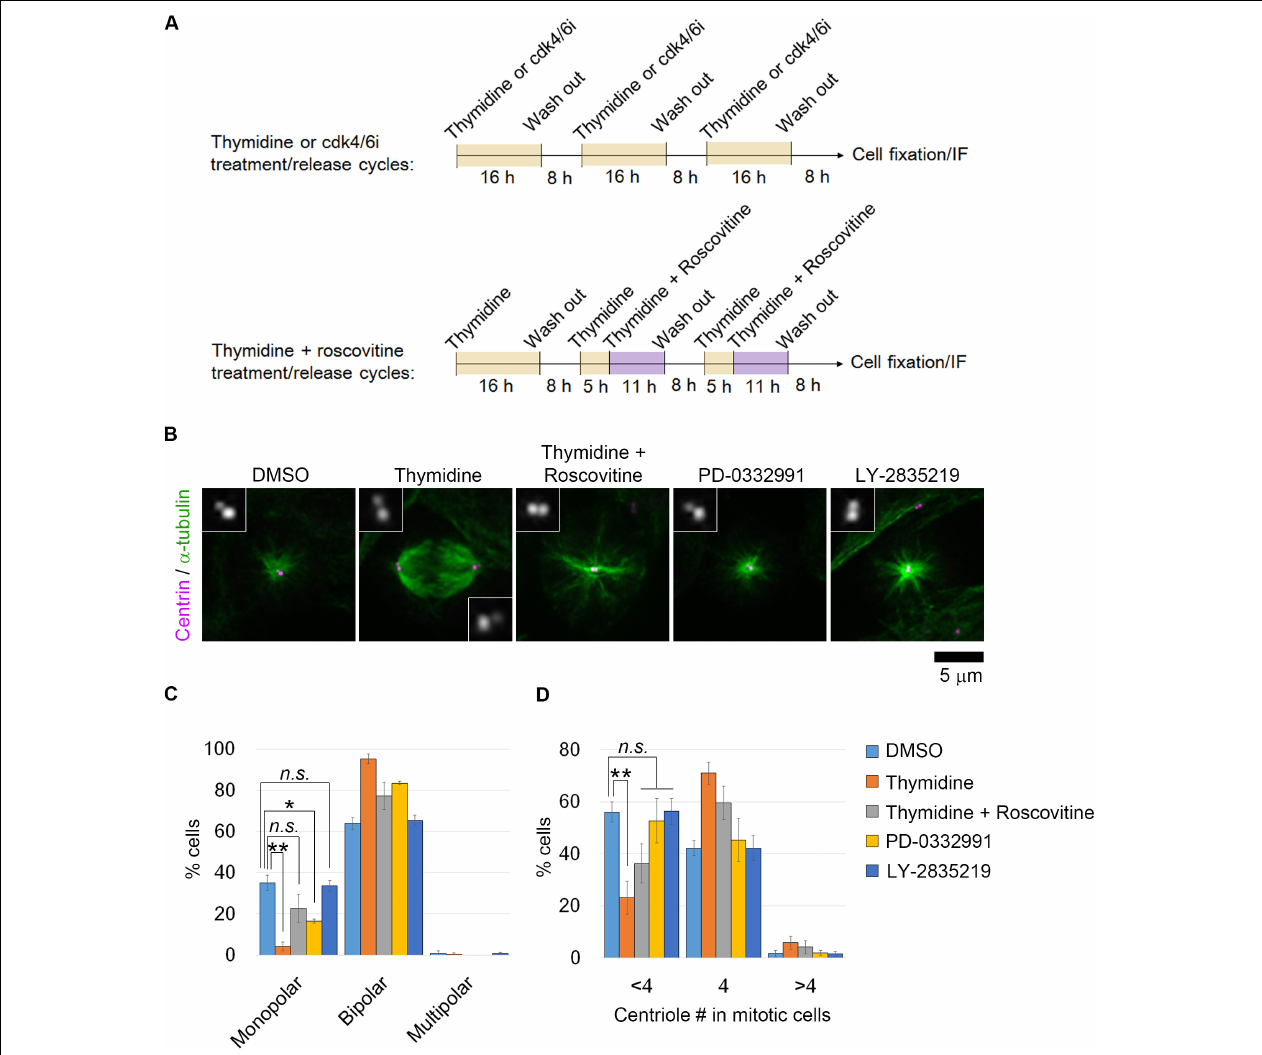
FIGURE 2 | Restoration of normal mitotic centrosome number and spindle bipolarity by intermittent extension of G1/S phase in haploid HAP1 cells. (A) Experimental scheme of inhibitors treatment/release cycles. (B) Immunostaining of α -tubulin and centrin in haploid cells after three cycles of inhibitors treatment/release. Insets show 3 × enlarged images of the centrioles. (C,D) Frequency of spindle polarities (C) or centriole numbers (D) in mitotic cells. Means ± SE of three independent experiments (* p < 0.05, ** p < 0.01, two-tailed t -test). At least 154 cells were analyzed per